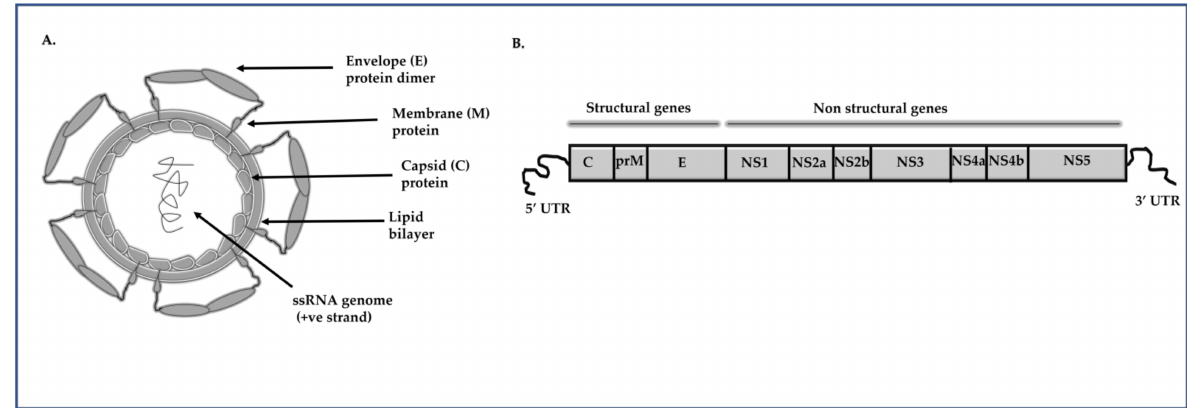
Figure 2. The Dengue virus (DENV) structure and genome. ( A ) General structure of DENV. ( B ) Genomic organization of